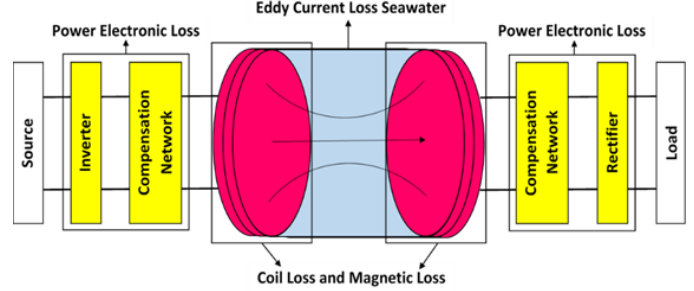
Figure 18. Various power losses in UWPT.